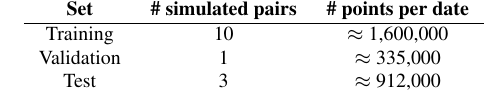
Table 2. Dataset